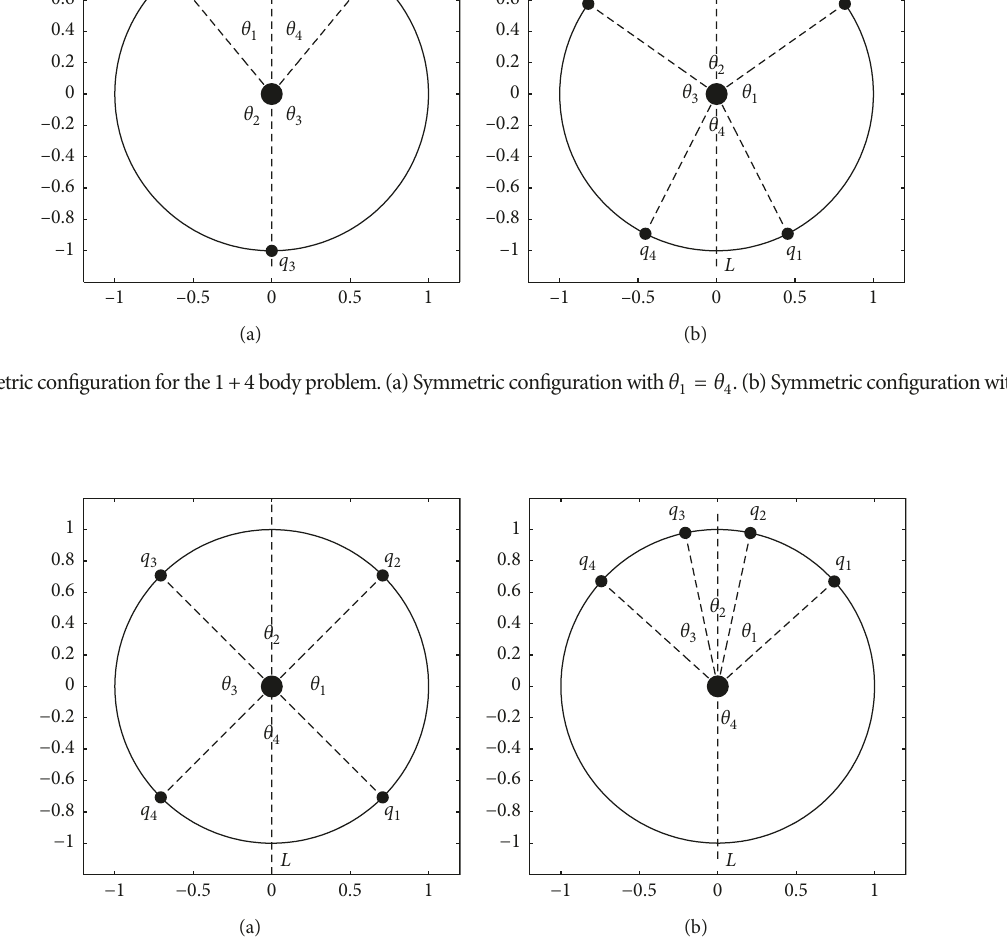
+ θ � π and θ + θ � π /3. (a) Square central configuration for 1 2 1 2